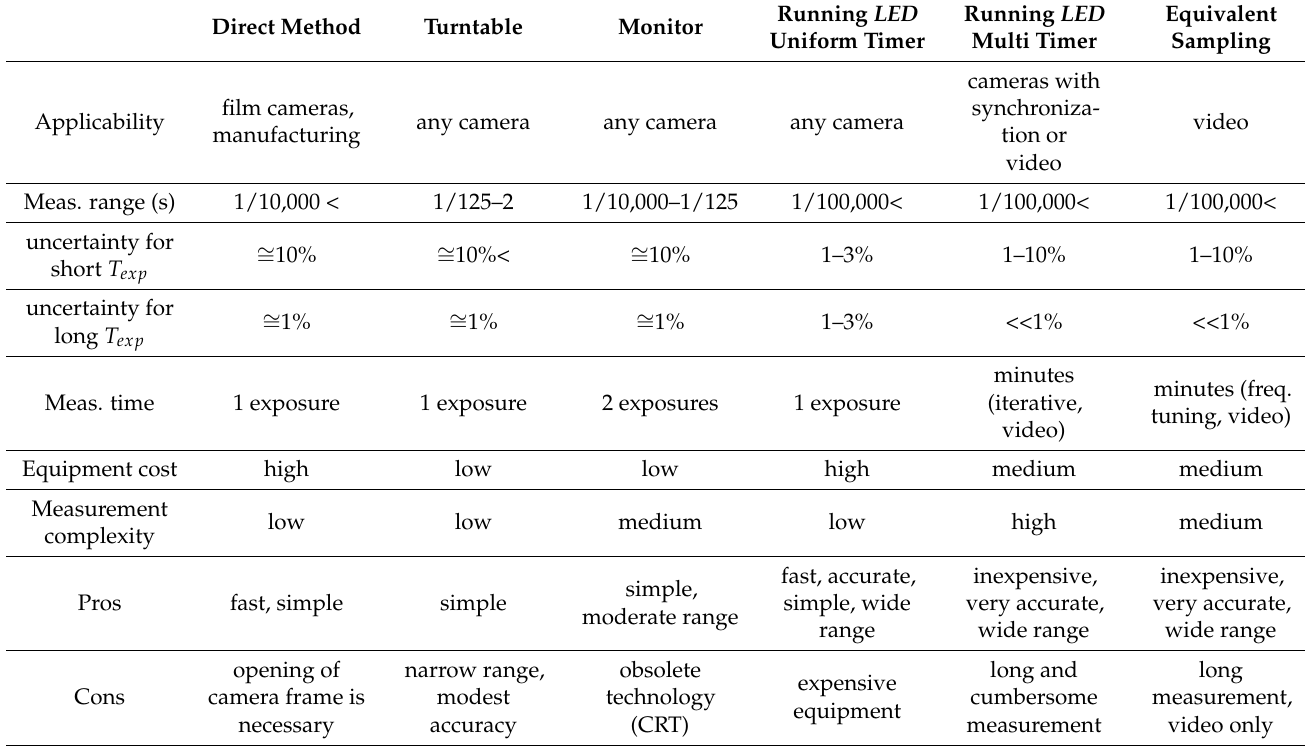
Table 8. Comparison of the discussed